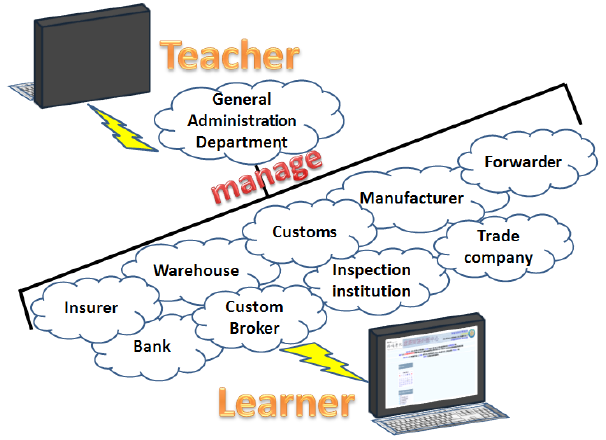
Figure 2 . Virtual international trade